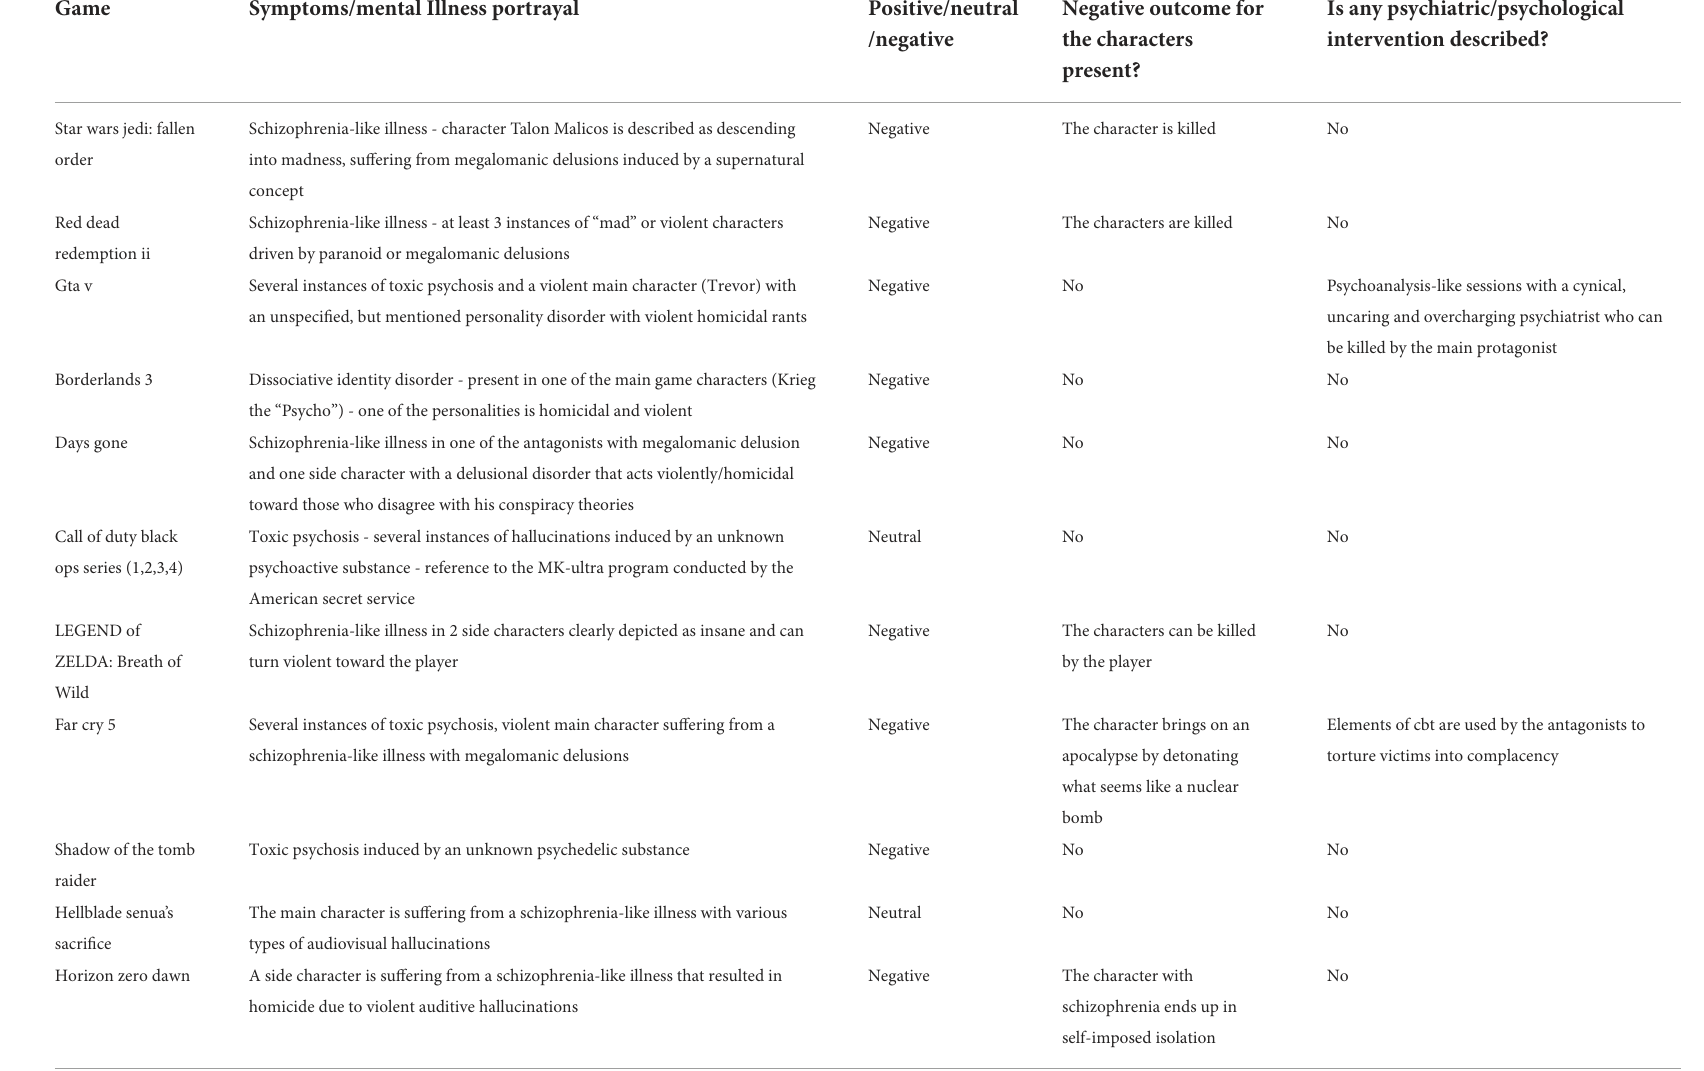
TABLE 1 Individual video game titles and a brief summary of the portrayed mental illness or depicted intervention. Game Symptoms/mental Illness portrayal Positive/neutral